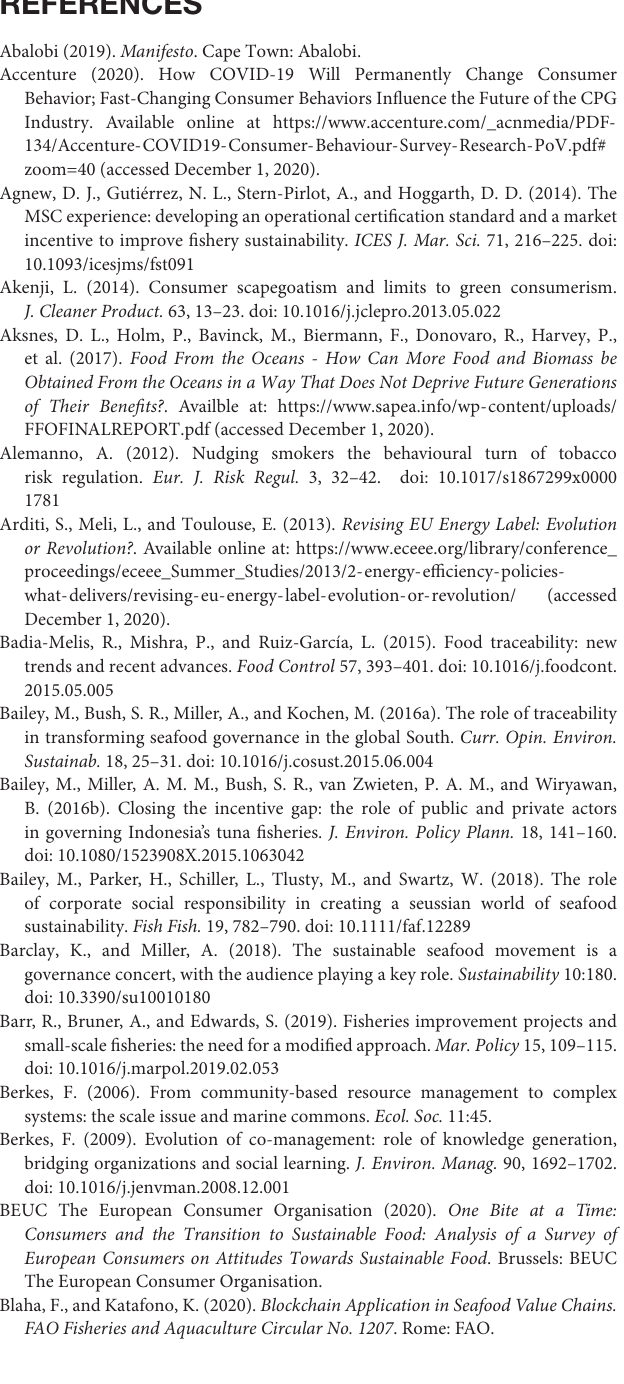
Supplementary Figure 1 | Differences between mandatory labeling and eco-labeling regarding consumers’ knowledge and decision-making.